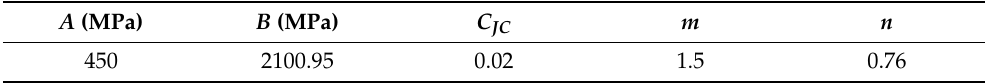
Table 2. The Johnson–Cook material model